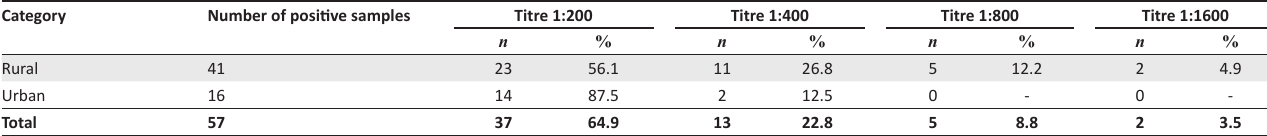
TABLE 2: Distribution of Brucella canis seroprevalence according to location and titre.